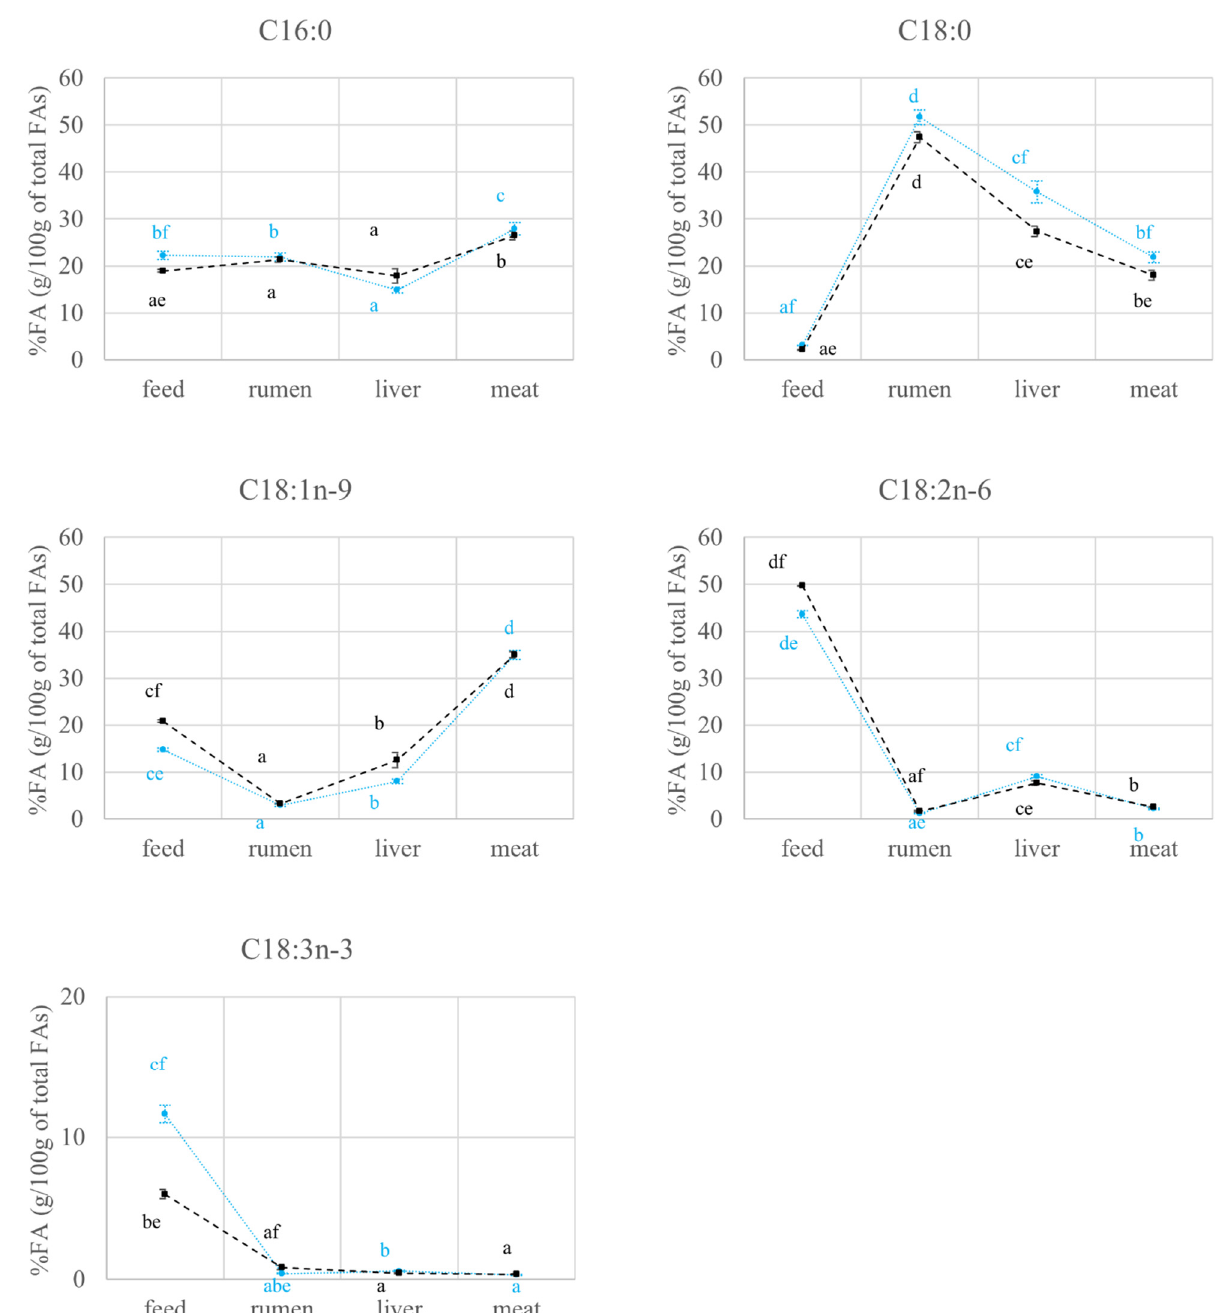
Figure 2. Variations (mean ± se) of FAs expressed as a percentage (g/100 g of total FAs) in various compartments (feed, rumen, liver, meat) of cull cows fed with diets based on C3 (C3 group, blue) and C4 (C4 group, black) plants. a, b, c, d: p < 0.05 within experimental group; e, f: p < 0.05 within compartment.